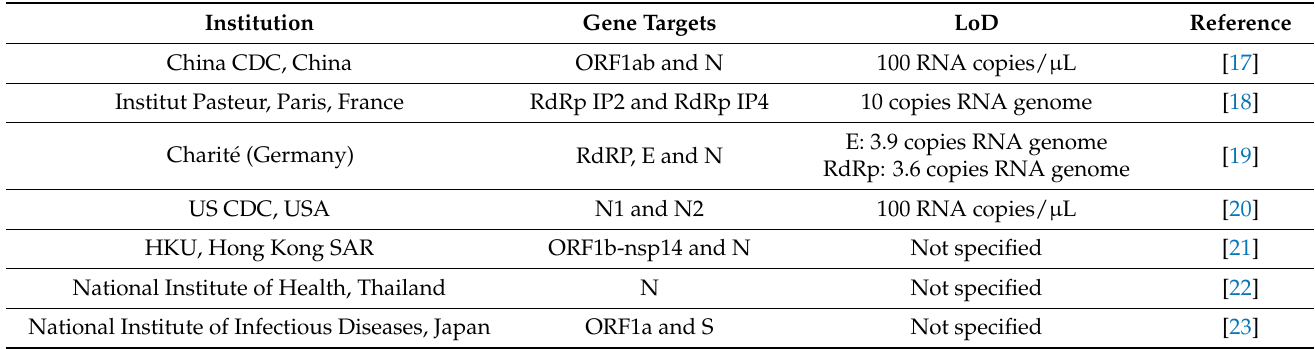
Table 1. Protocols validated by the WHO for detection of SARS-CoV-2 by real-time